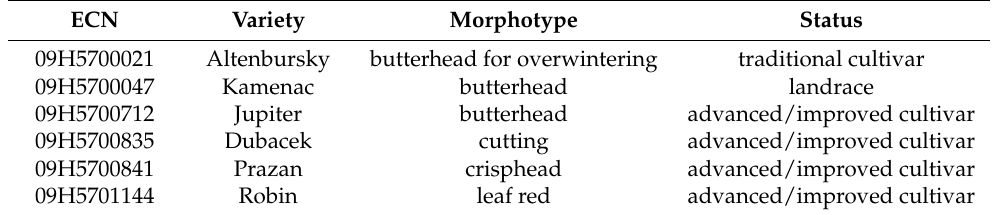
Table 1. List of lettuce varieties used in this study. ECN Variety Morphotype Status 09H5700021 Altenbursky butterhead for overwintering traditional cultivar 09H5700047 Kamenac butterhead landrace Jupiter butterhead advanced/improved cultivar cutting advanced/improved